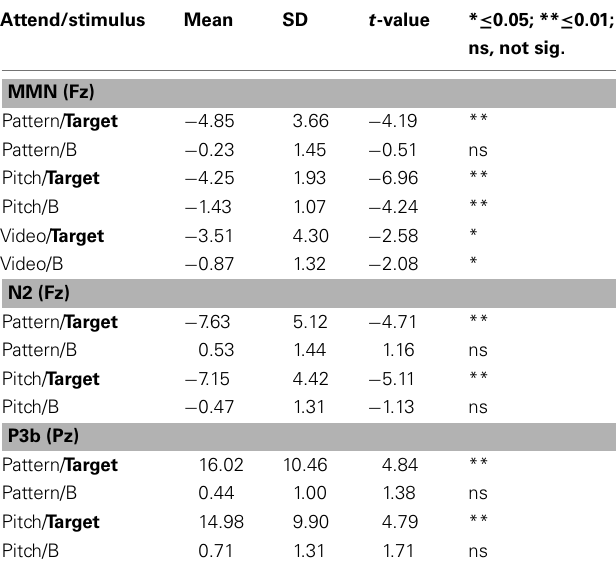
Table 1 | ERP component mean